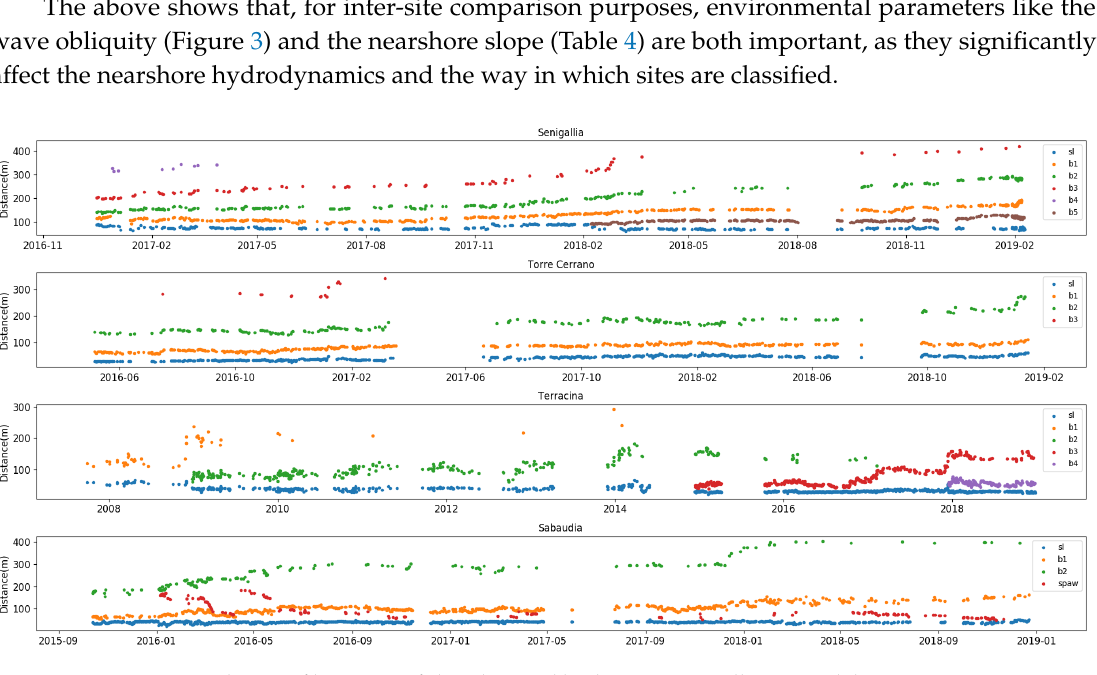
Figure 4. Time evolution of locations of shoreline and barlines in Senigallia, Torre del Cerrano, Terracina and Sabaudia. Each dot represents the daily-averaged location of the relative beach